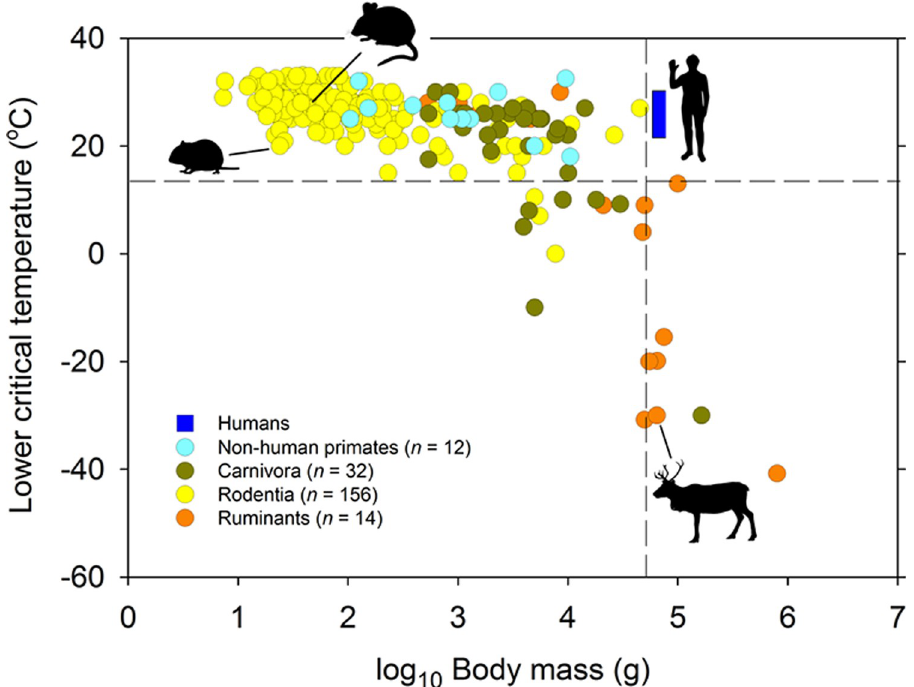
Fig 2. Relationship between T lc (˚C) and body mass (g) in mammals. The T lc is defined as the ambient temperature below which the rate of metabolic heat production must be increased in order to maintain homeothermy. Of all species with T lc above the global mean surface temperature (14˚C, horizontal dashed line; [11]), humans ( T lc range from 23 to 33˚C; [16,17])are the most massive, and of all species with a body mass above 50 kg (vertical dashed line), humans have the highest T lc . For clarity, the figure includes only data for a limited number of taxa (humans, Carnivora, nonhuman primates, Rodentia, ruminants). However, the shape of the relationship between body mass and T lc does not change when data for other groups are included (Chiroptera, Cingulata, Dasyuromorphia, Diprotodontia, Erinaceomorpha, Eulipotyphla, Hyracoidea, Lagomorpha, Macroscelidea, Monotremata, Peramelemorphia, and Soricomorpha). Species data indicated by silhouettes are, clockwise from the left, for voles ( M . arvalis ), mice ( M . musculus ), humans, and reindeer ( R . tarandus ). Data from [12,13,18,19]. T lc , lower critical